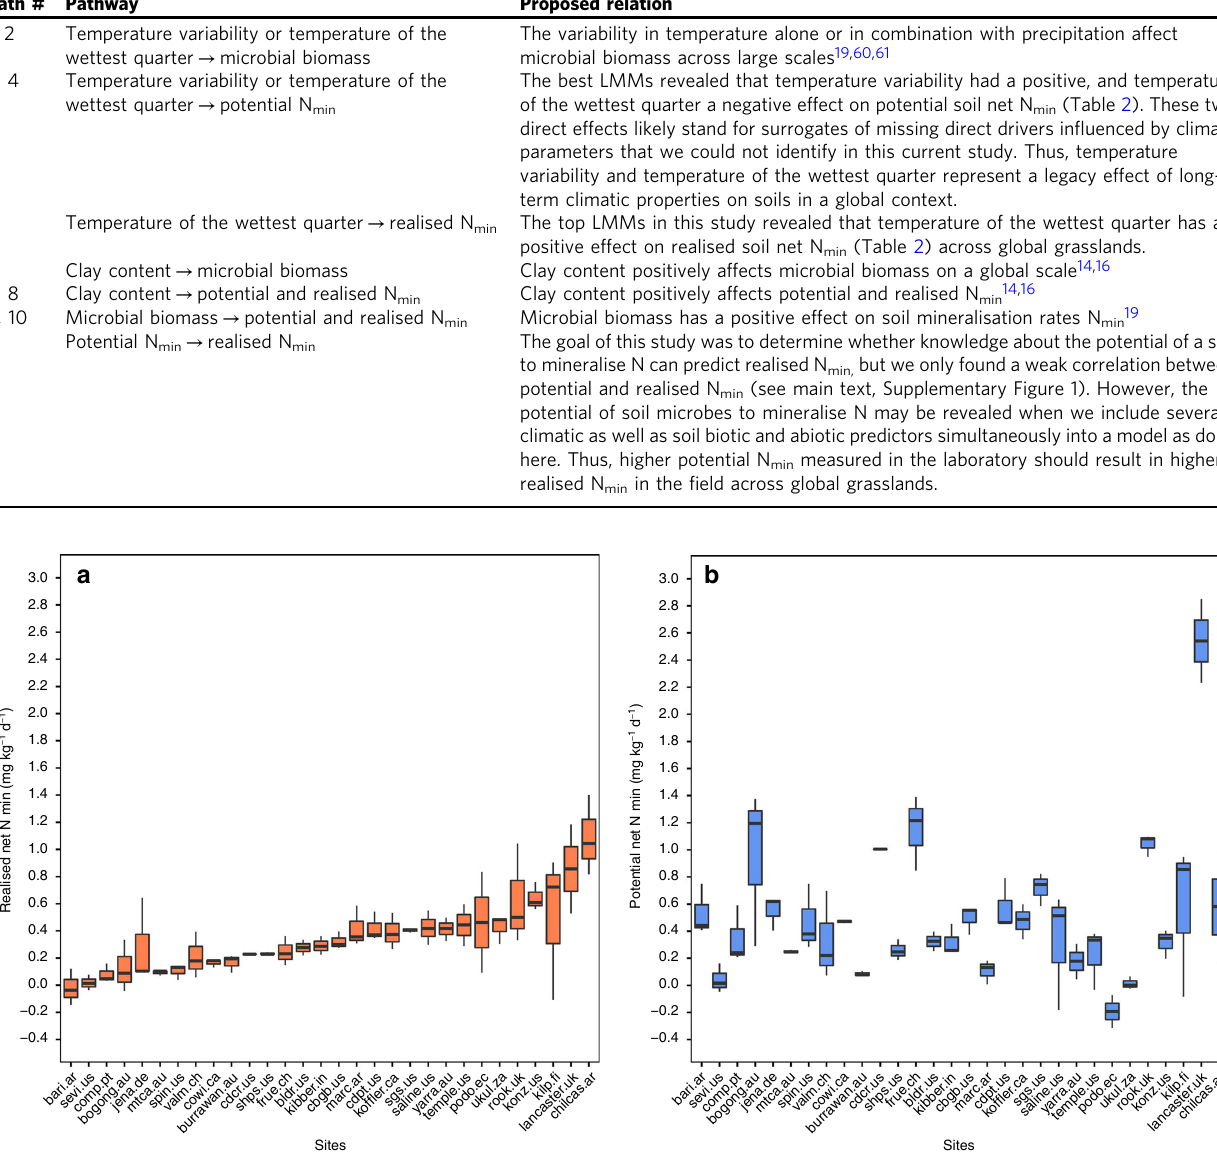
Fig. 4 Global patterns in realised and potential soil net N mineralisation (soil net N min ). a Realised soil net N min at 30 NutNet sites ordered according to increasing realised soil net N min . b Potential soil net N min at the 30 NutNet sites. Order of sites according to a . The box represents the median (50th percentile), 25th and 75th percentile of the data for each site. The whiskers represent 1.5 times the inter-quartile range. Source data are provided in